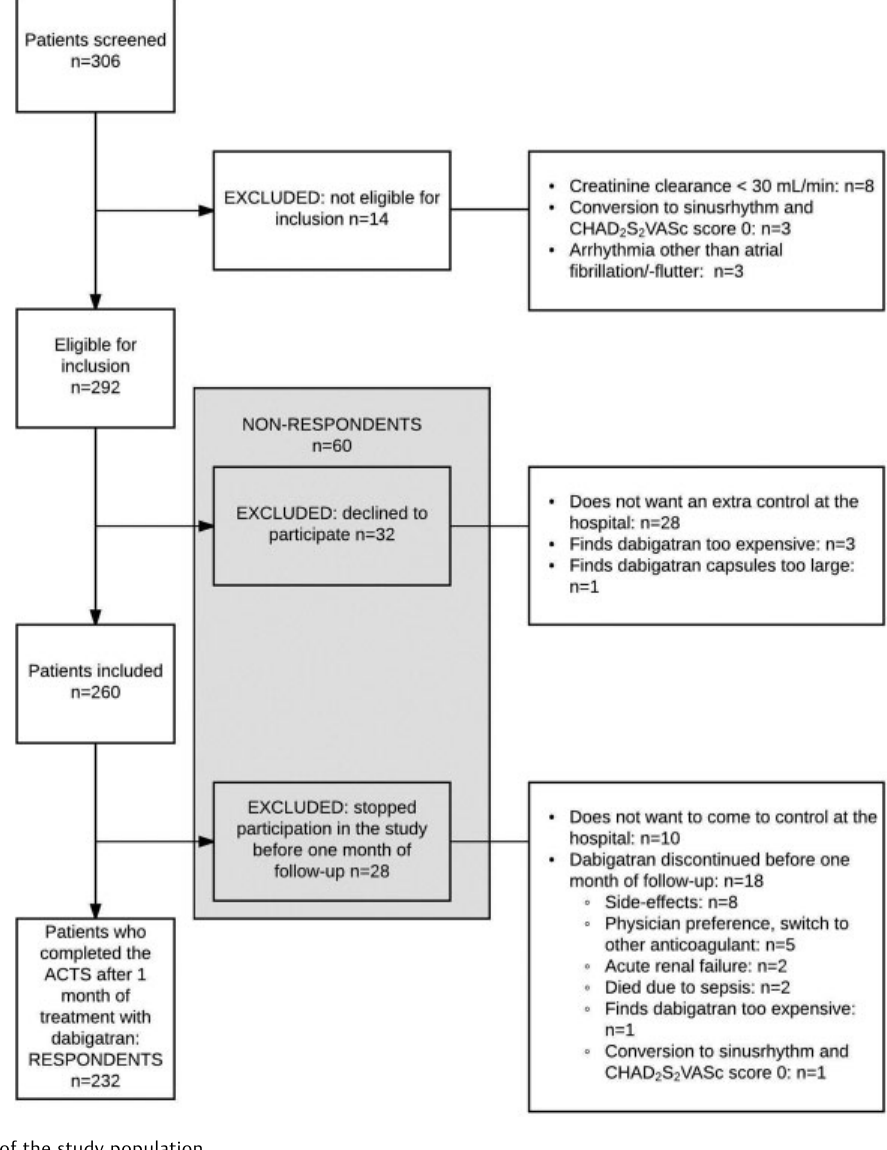
Fig. 1 Flowchart of the study